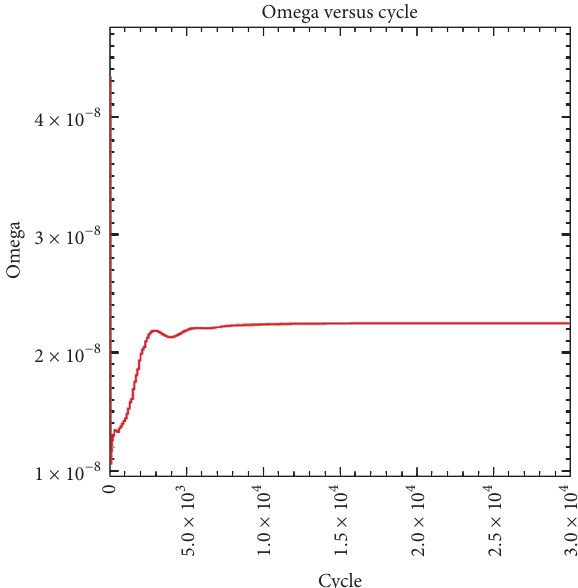
Figure 4: Plot of the orbital angular velocity, 𝜔 in geometrized units (cm −1 ) versus cycle number. When 𝜔 stops changing the simulation has reached a circular binary orbit solution. This run was extended to over 30,000 cycles, corresponding to ≈ 20